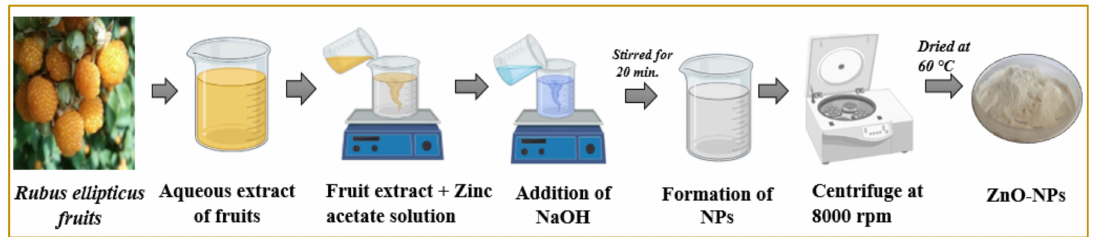
Figure 1. Schematic representation of biosynthesis of ZnO-NPs using fruit